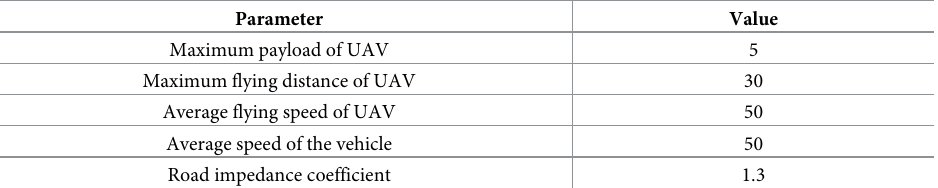
Table 1. Parameters of the